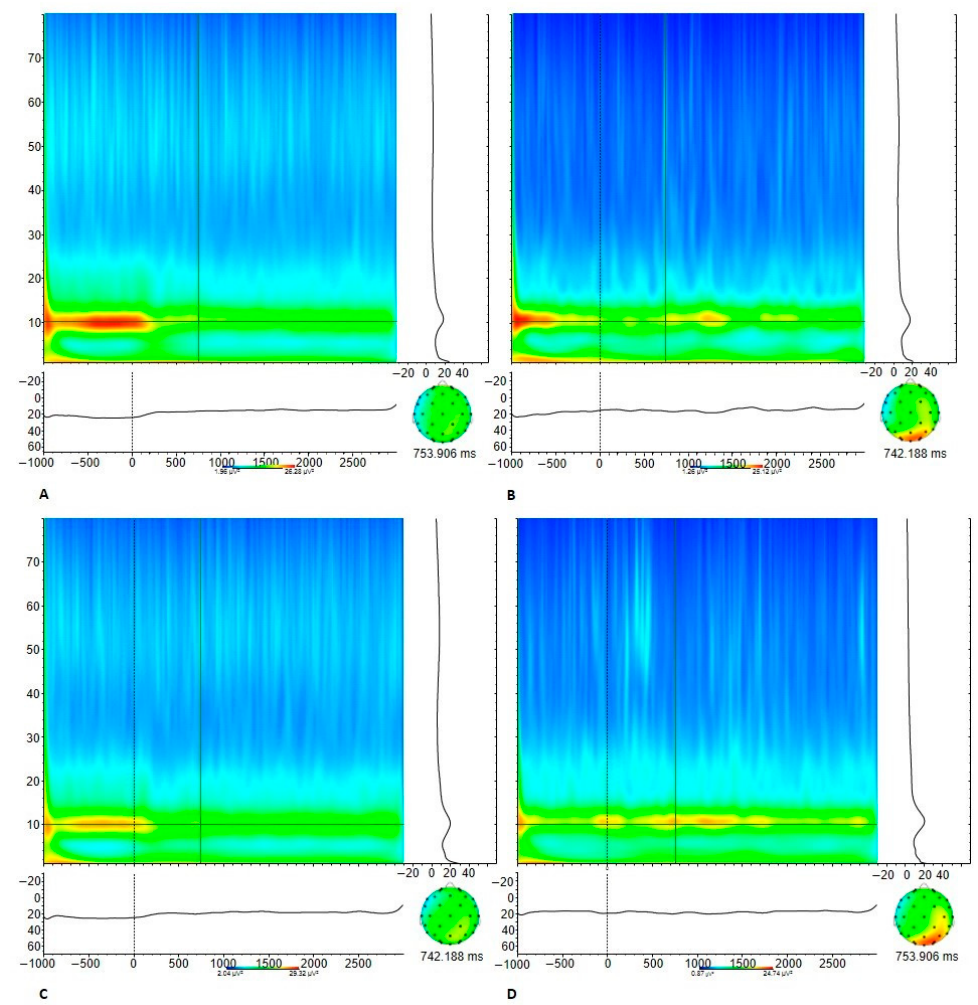
Figure 3. Alpha ERD (at site C4) in aggression condition for ( A ) the delinquent group and. ( B ) controls; and in neutral condition for the ( C ) delinquent group ( D ) controls.